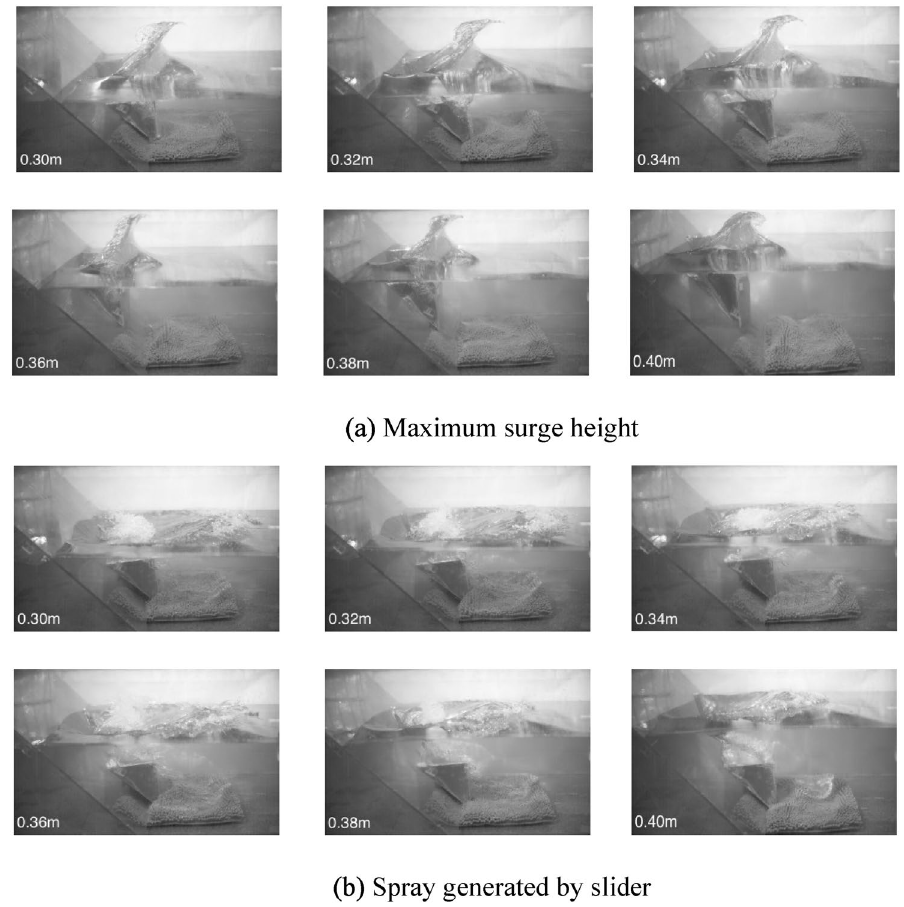
Figure 4. Surge form ( a ) maximum surge height ( b ) spray generated by